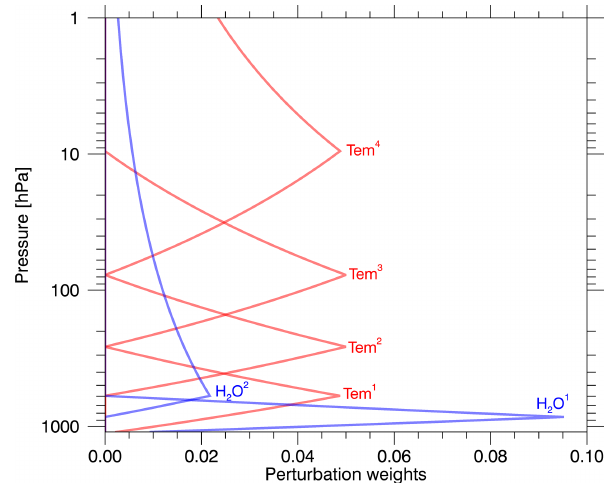
Figure 3. The vertical representations of the temperature and water vapour Jacobians are shown. These represent triangular perturba- tions as opposed to rectangular (evenly weighted) vertical perturba-